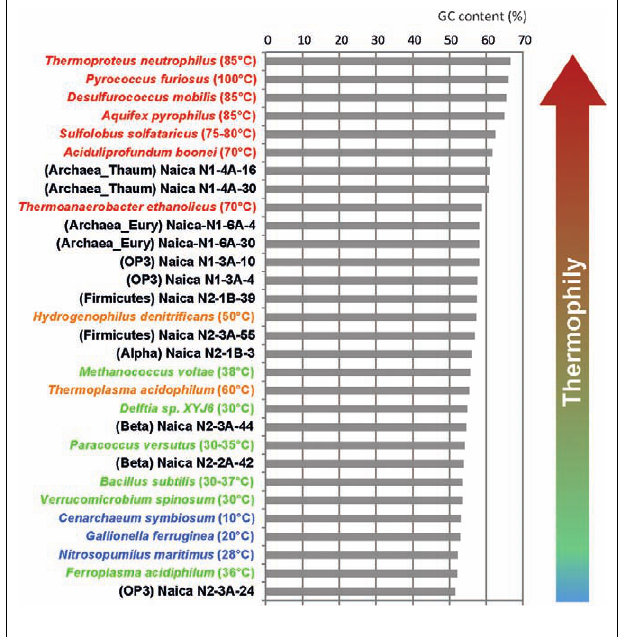
FIGURE 5 | Comparative histogram showing the GC content of the same 16S rRNA region in Naica clones and in a wide range of microbial species growing at different